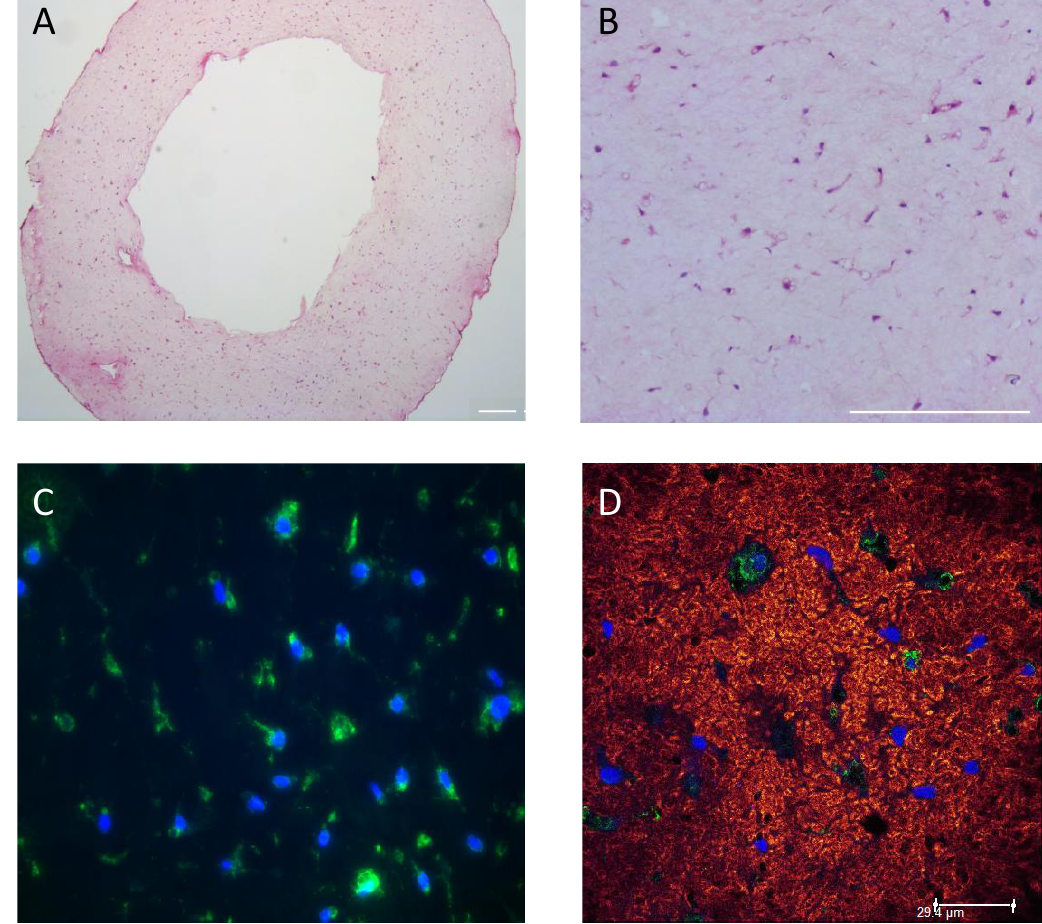
Figure 4. Histological and immunohistological analysis of EHM-ring sections. HE staining of an EHM ring section showing even distribution of the cells throughout the EHM ring structure. EHM ring was formed using 1.5 mg/mL collagen concentration and 1000 CF cells/ μ L gel and was fixed and stained 24 h after casting. Darker dots implicate CF. Magnification 5× ( A ); or 20× ( B ). Bars represent 200 µm. Vimentin (green) and DAPI (blue) staining ( C ); and Z-stack image of CNA35 (red) and Vimentin (green) staining nuclei are blue (DAPI) ( D )(bar represents 29.4 μ m).